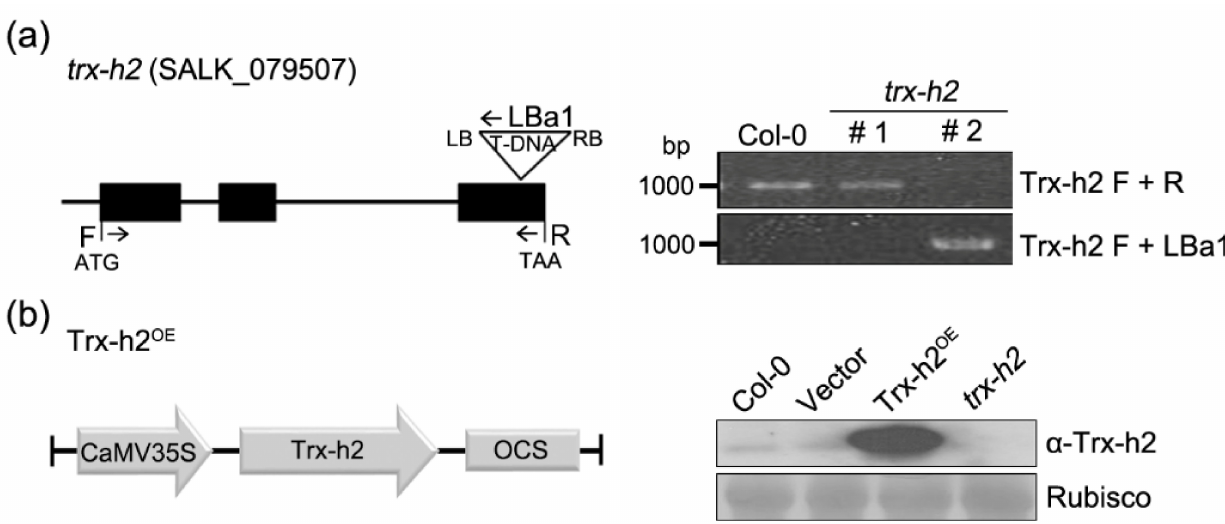
Figure 2. Identification of trx-h2 knockout mutant lines and transgenic Trx-h2 overexpression ( Trx-h2 OE ) lines by PCR. ( a ) schematic showing the location of the T-DNA insertion in the trx-h2 mutant (SALK_079507), and gel image showing the results of PCR-based genotyping. T-DNA was inserted in the third exon of the Trx-h2 gene. Primers (F, R, and LBa1) used for genotyping the plants are indicated in the schematic. The trx-h2 knockout mutant lines #1 and #2 were confirmed by PCR. ( b ) schematic showing the construct used to generate Trx-h2 OE lines, and results of western blot analysis. The Trx-h2 gene was expressed under the control of the cauliflower mosaic virus 35S promoter (CaMV35S) and octopine synthase terminator (OCS). The Trx-h2 protein was detected by western blotting using anti-Trx-h2 antibody. Rubisco was used as a loading